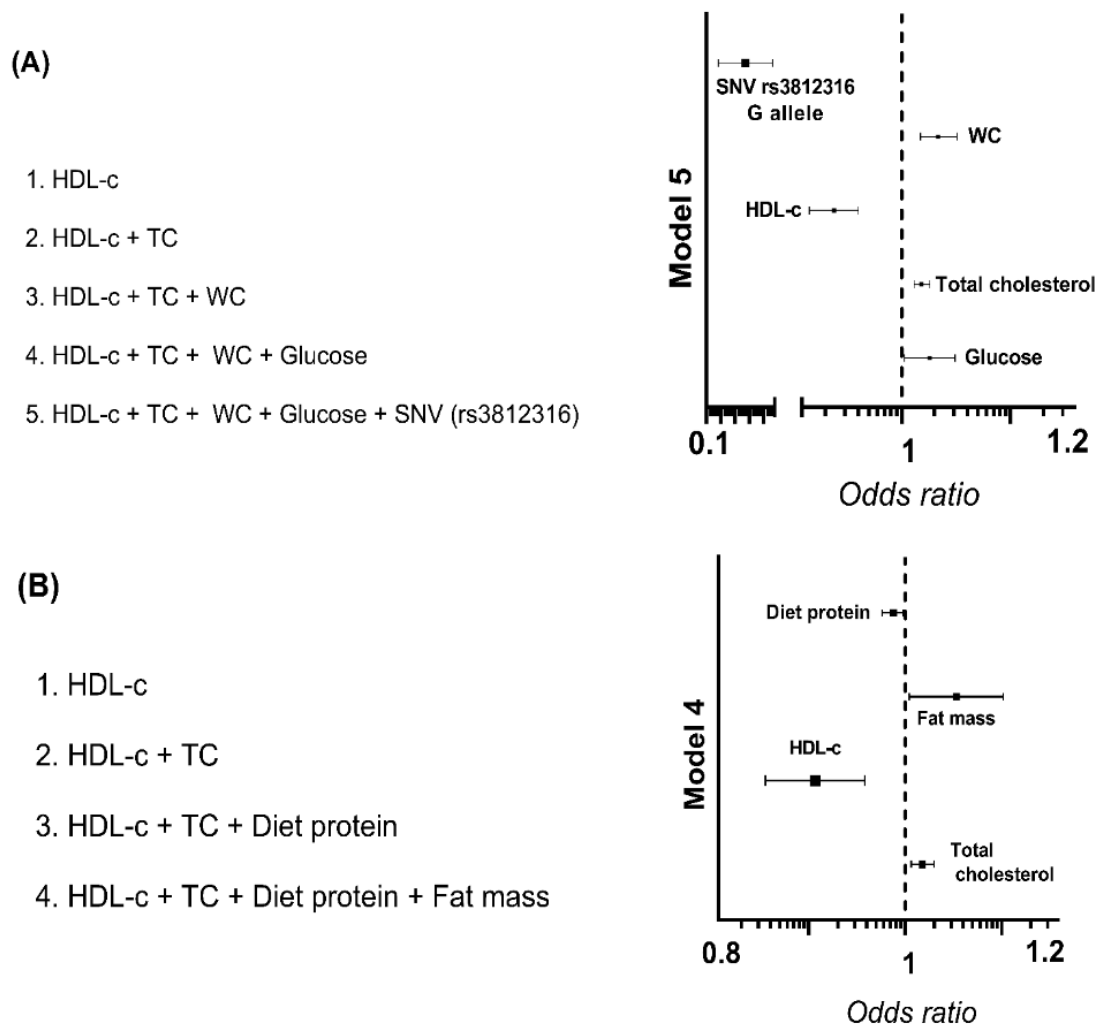
Figure 3. Factors associated with hypertriglyceridemia in women and men. Logistic regression models of hypertriglyceridemia in ( A ) women and ( B ) men. Binary logistic regression was performed with hypertriglyceridemia (triglycerides ≥ 150 mg/dL) as a dependent variable. Lines represent the Odds Ratio and the 95% Confidence Interval. A p -value < 0.05 was considered statistically significant. HDL-c: High-density lipoprotein cholesterol, TC: Total cholesterol, WC: Waist circumference, SNV: Single nucleotide variant.